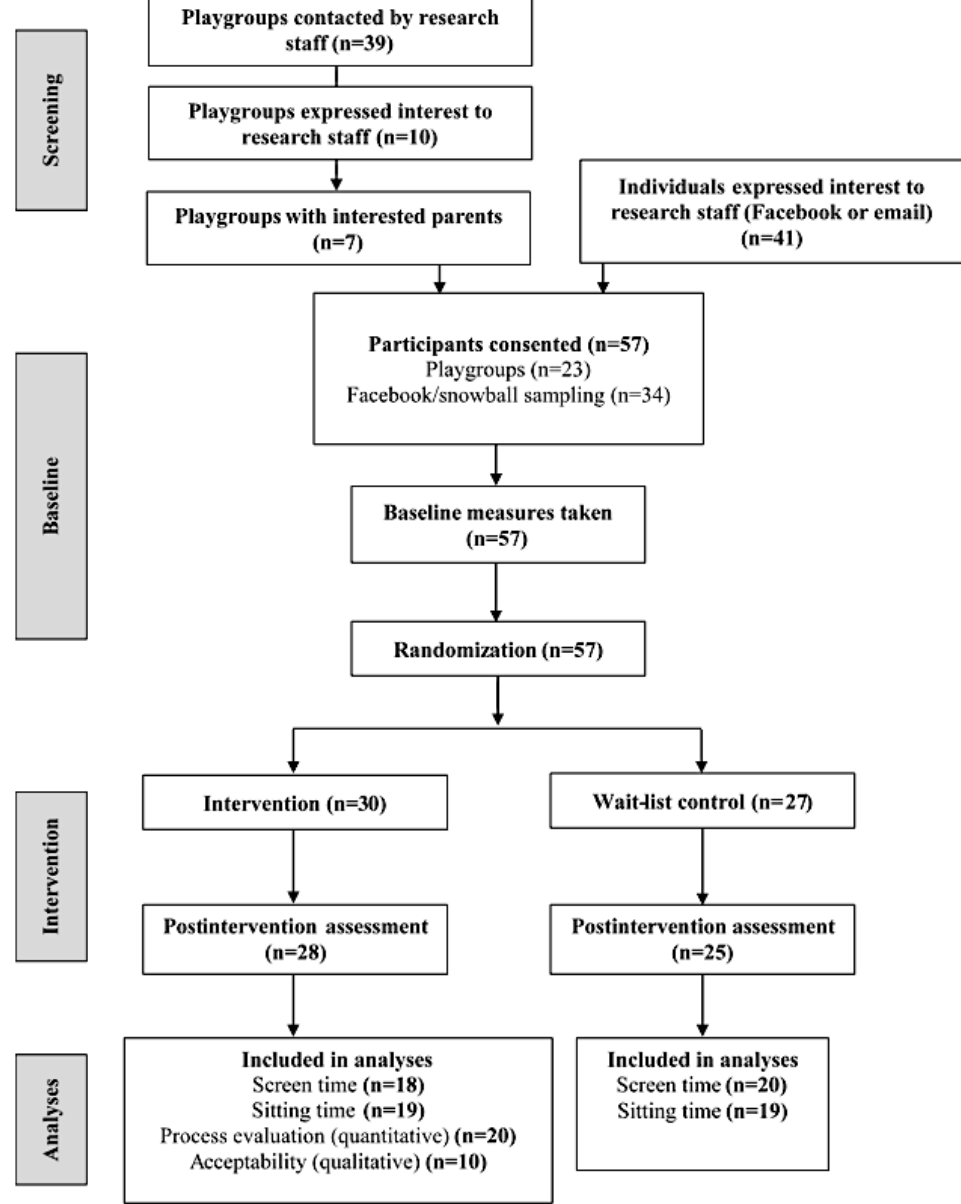
Figure 1. Trial flow